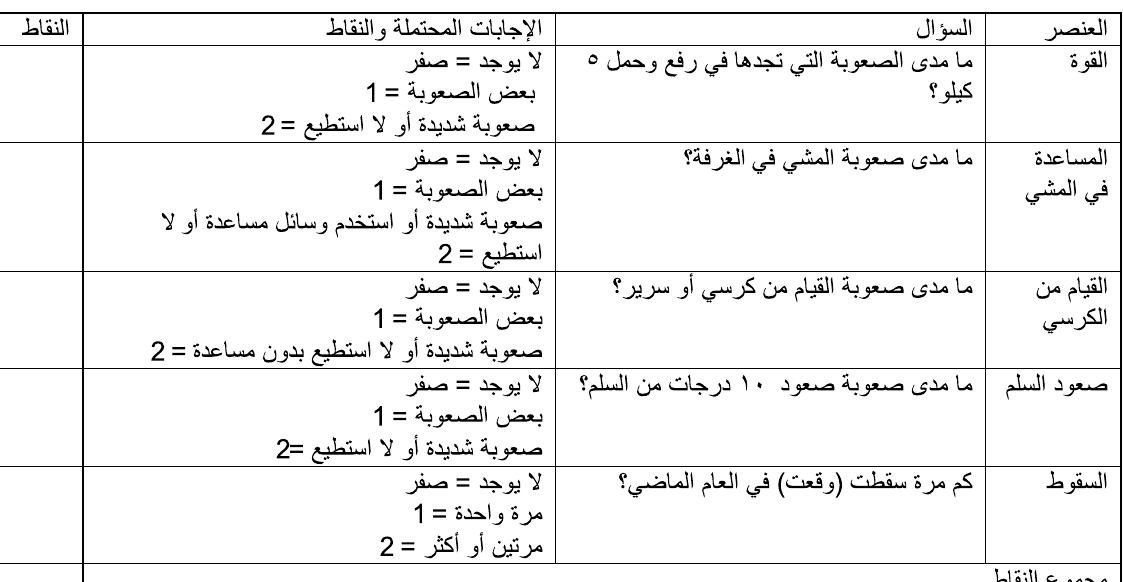
Table 5 Arabic SARC-F